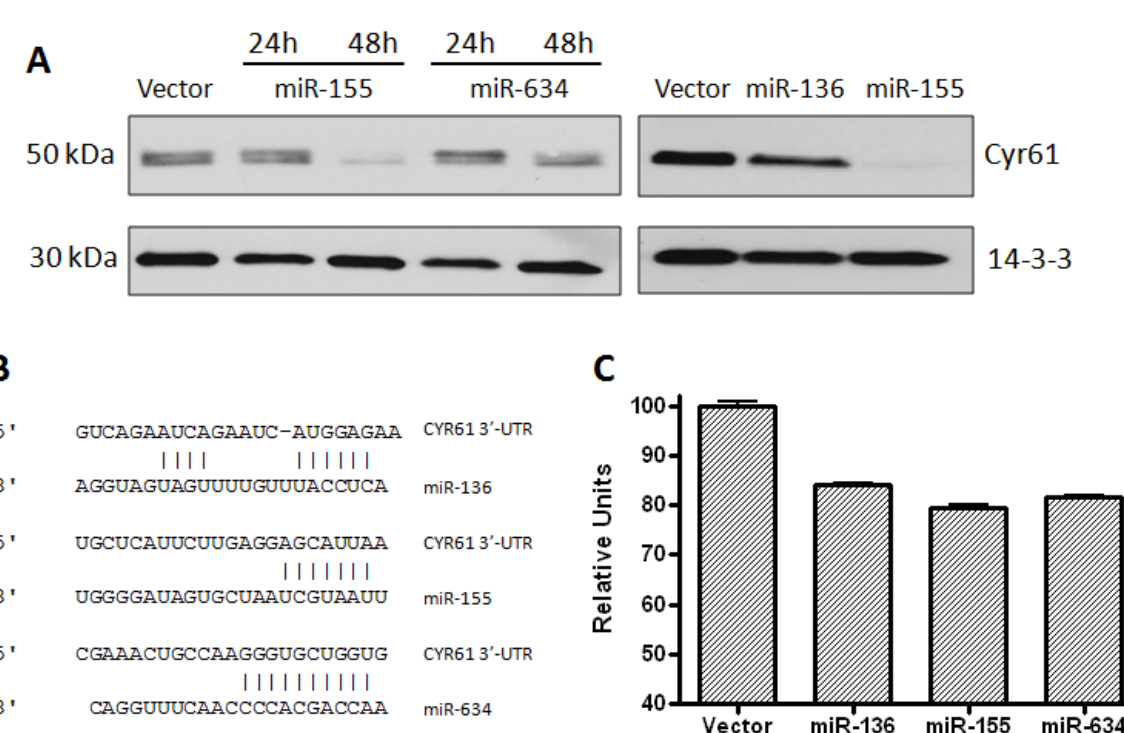
Figure 1. CYR61 is a target for miR-136, miR-155, and miR-634. (A) Western blot showing levels of CYR61 in LN229 cells transfected with miRNA-expressing Block-iT plasmids. 14-3-3 antibody was used to show equal loading of cellular lysates. (B) Diagram depicting the predicted binding sites of the mic (cid:85)(cid:82)(cid:53)(cid:49)(cid:36)(cid:86)(cid:3) (cid:87)(cid:82)(cid:3) (cid:87)(cid:75)(cid:72)(cid:3) (cid:22)(cid:182)(cid:56)(cid:55)(cid:53)(cid:3) (cid:82)(cid:73)(cid:3) cyr61 mRNA sequence. (C) Luciferase assays of HeLa cells co-nucleofected with cyr61 (cid:22)(cid:182)(cid:56)(cid:55)(cid:53)(cid:3) (cid:68)(cid:81)(cid:71)(cid:3) miRNA-expressing plasmids. Firefly and Renilla values were determined at 24 h post-nucleofection of cells. The data represents the ratio between Renilla values and